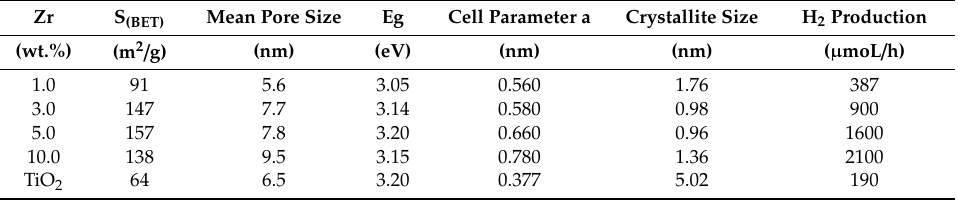
Table 1. Textural properties, band gap (Eg) and H 2 production rates of the Ti–Zr samples. Zr S (BET) Mean Pore Size Eg Cell Parameter a Crystallite